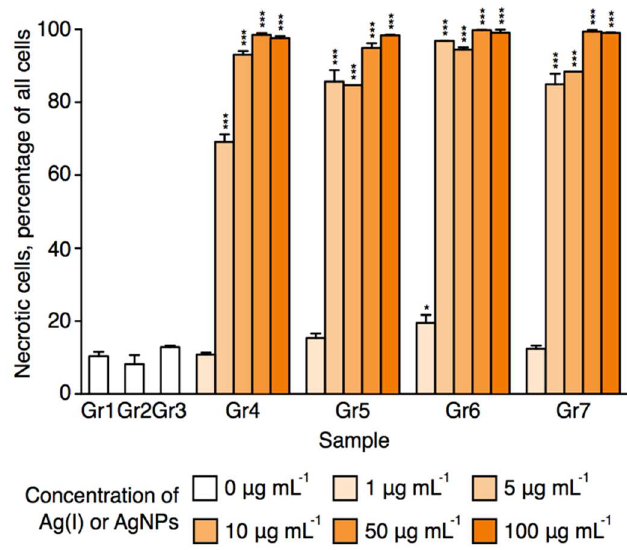
Figure 8. Percentage of necrotic human melanoma Hs 294T cells. Human melanoma (Hs 294T) cancer cells were treated with 1, 5, 10, 50, and 100 μg mL −1 silver nanoparticles (AgNPs) or Ag(I) ions for 24 h or were treated with culture medium as a control (see Table 2 for a description of the groups). Percentages of necrotic cells were calculated as means ± the standard error of the mean of three independent experiments, each performed with triplicate wells for each treatment group. * p < 0.05; *** p < 0.0001.